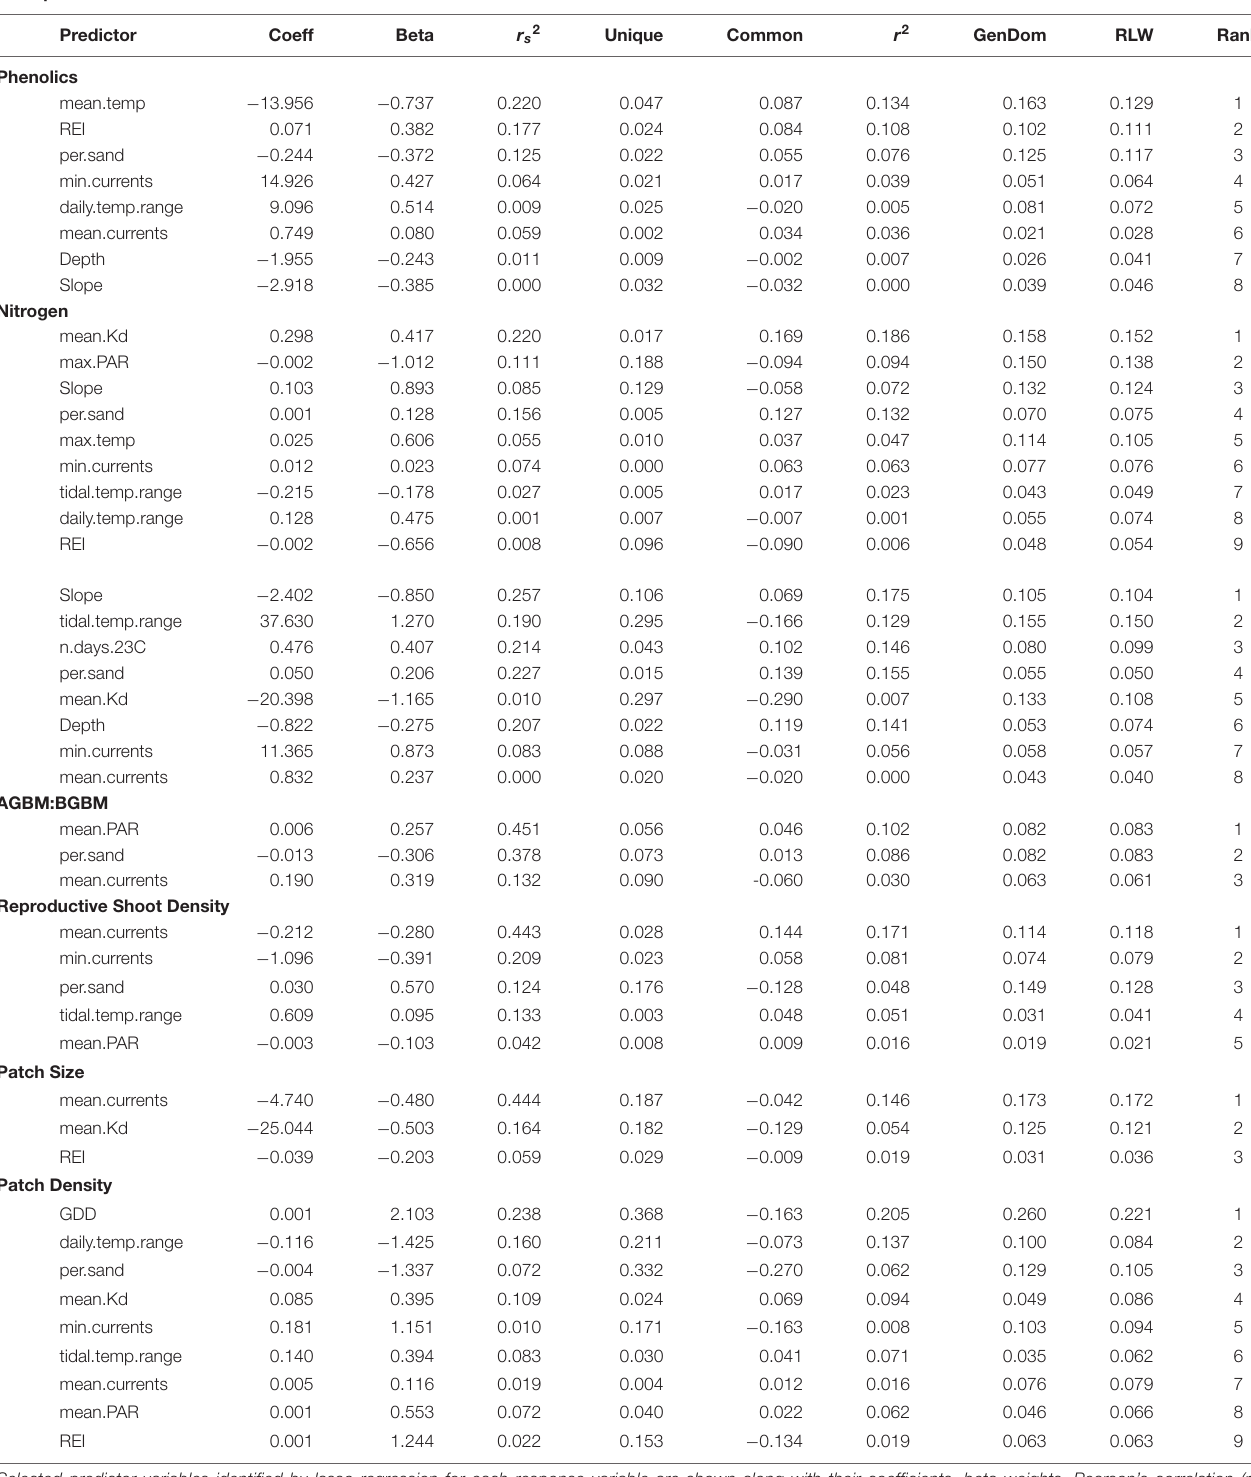
TABLE 3 | Regression results for biological metrics of